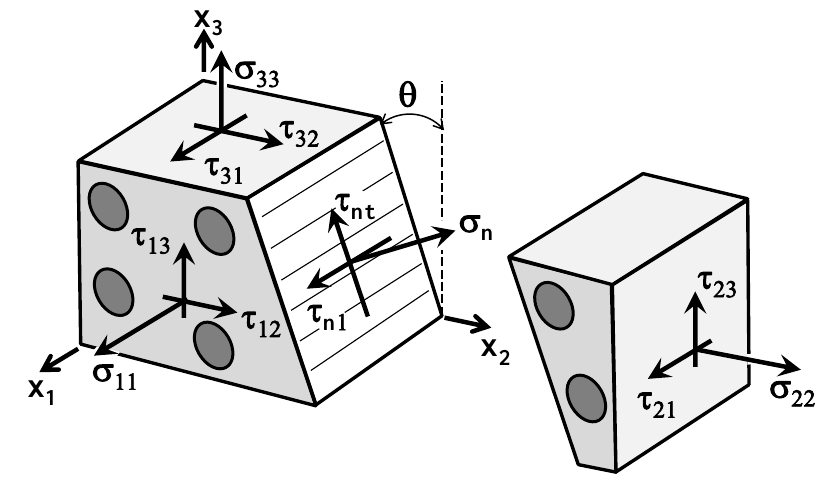
Figure 3. Stress state associated with fiber reinforced composites where σ n , τ nt and τ n 1 are the stresses on the action plane and θ is the rotation of 2-face about the 1-axis (Adapted from